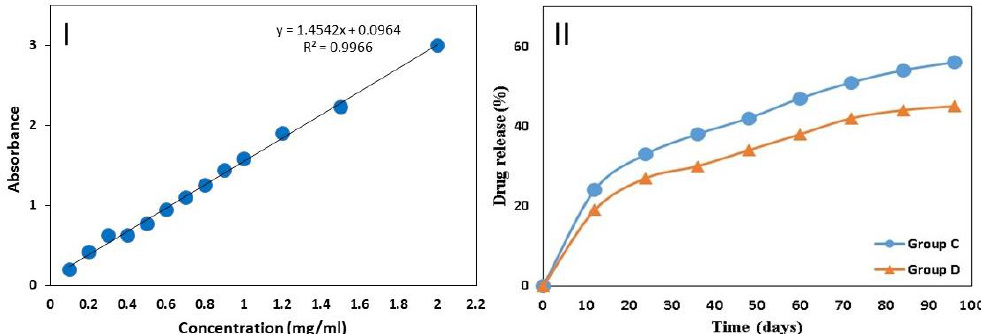
Figure 3. ( I ) External standard linear curve of cefuroxime with limit of detection (LOD = 0.198298). ( II ) In vitro drug release profile Cefuroxime-ROE-AgNPs/BIOD. Group (C) C — 99% BIOD with 1% Cefuroxime-ROE-AgNPs nanontibiotic, (1:1) and Group (D) D — 98% BIOD with 2% Cefuroxime-ROE-AgNPs nanontibiotic (1:3).